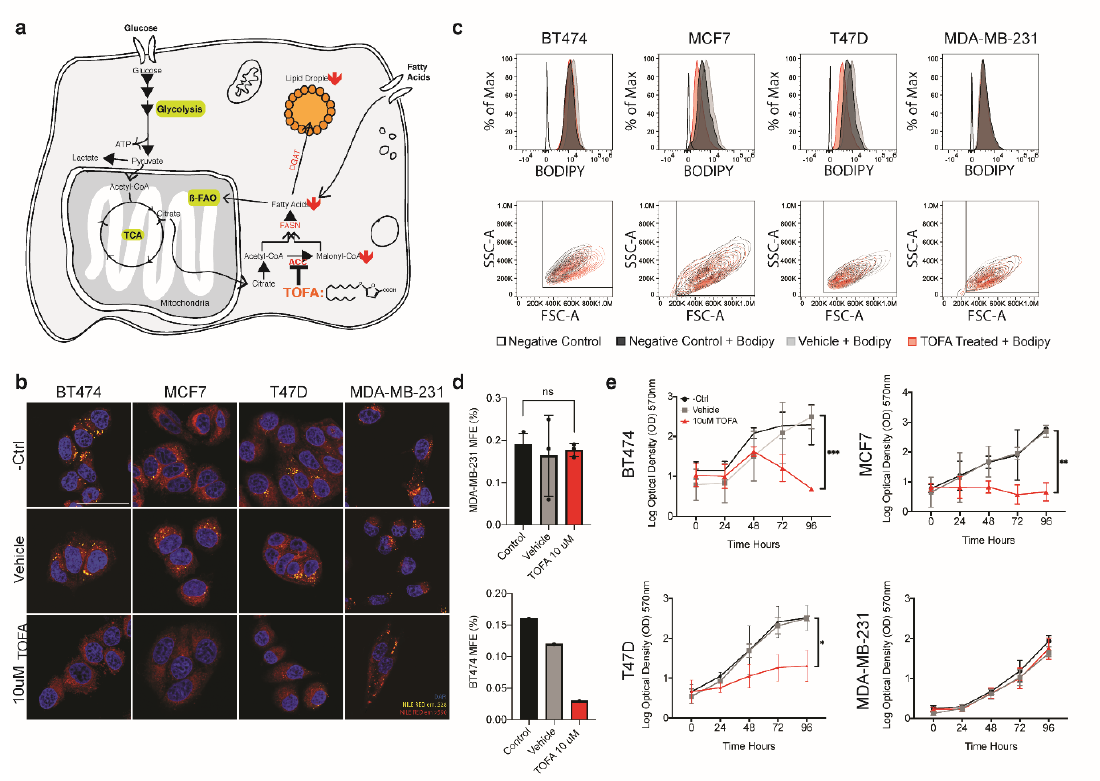
Figure 4. TOFA treatment reveals lipid metabolic addiction in a panel of breast cancer cell lines. ( a ) Schematic depicting the e ff ects of TOFA treatment on lipid metabolism. ( b ) Confocal microscopy of lipid droplets in the cell lines used in this study. Lipid droplets were visualized for control, vehicle, and following 48 h of 10 µ M TOFA treated with Nile Red. The scale bar represents 50 µ m. ( c ) FACS profile of cells treated with media, vehicle or TOFA for 48 h. From top to bottom, BODIPYTM signal across the treatment groups, side scatter vs. forward scatter plots across the treatment groups. ( d ) Second generation mammosphere forming e ffi ciency for MDA-MB-231 and BT474 following pre-treatment with TOFA, vehicle or regular growth media ( n = 2). ( e ) Growth of each cell line over time in the presence of 10 µ M TOFA, vehicle or growth media. Significance was calculated using the two-